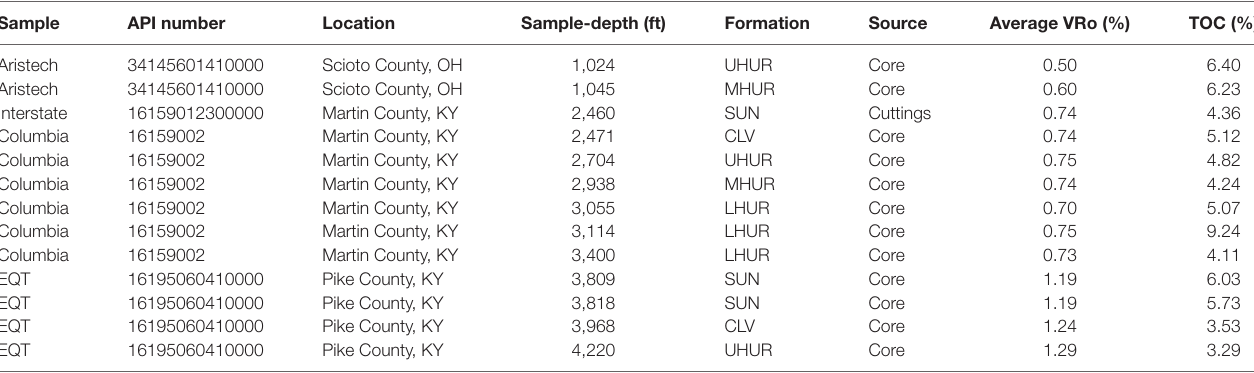
Table 1 | Sample locations and lithology